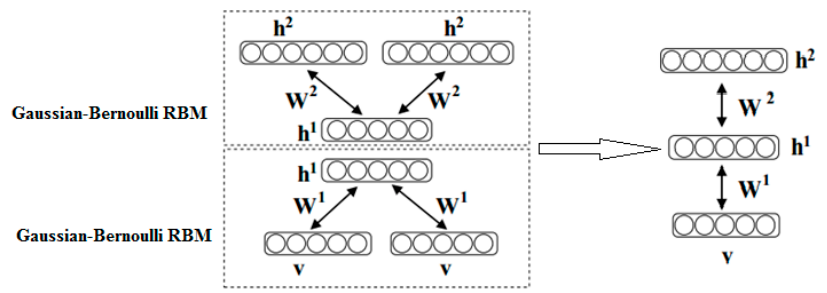
Figure 3. A Gaussian-Bernoulli Deep Boltzmann Machine.